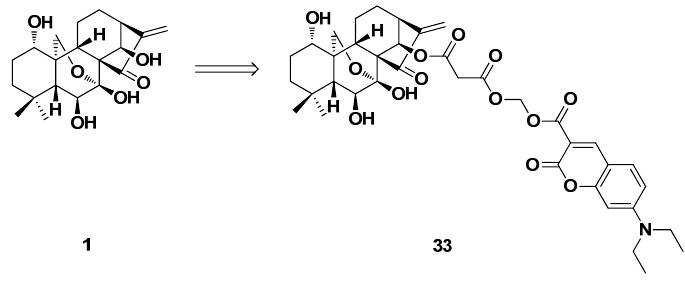
Figure 16. The oridonin fluorescent probe 33 .